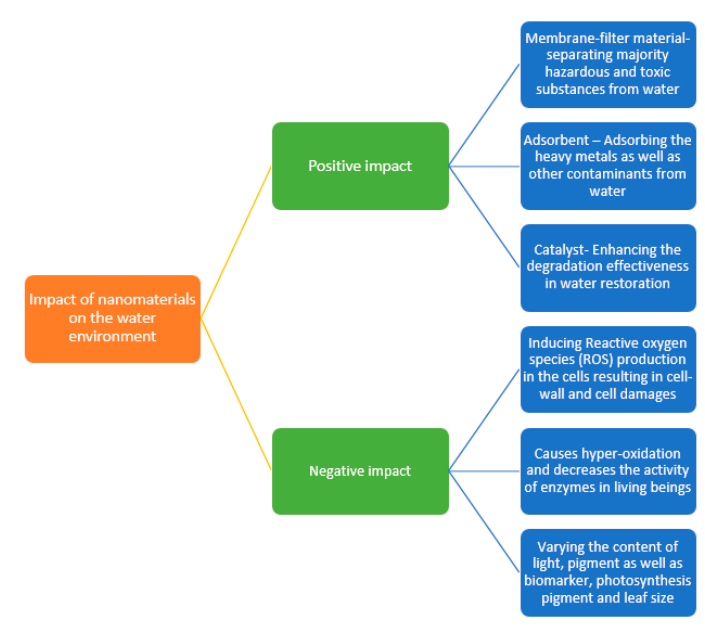
Figure 2. Impact of nanomaterials on the water environment.